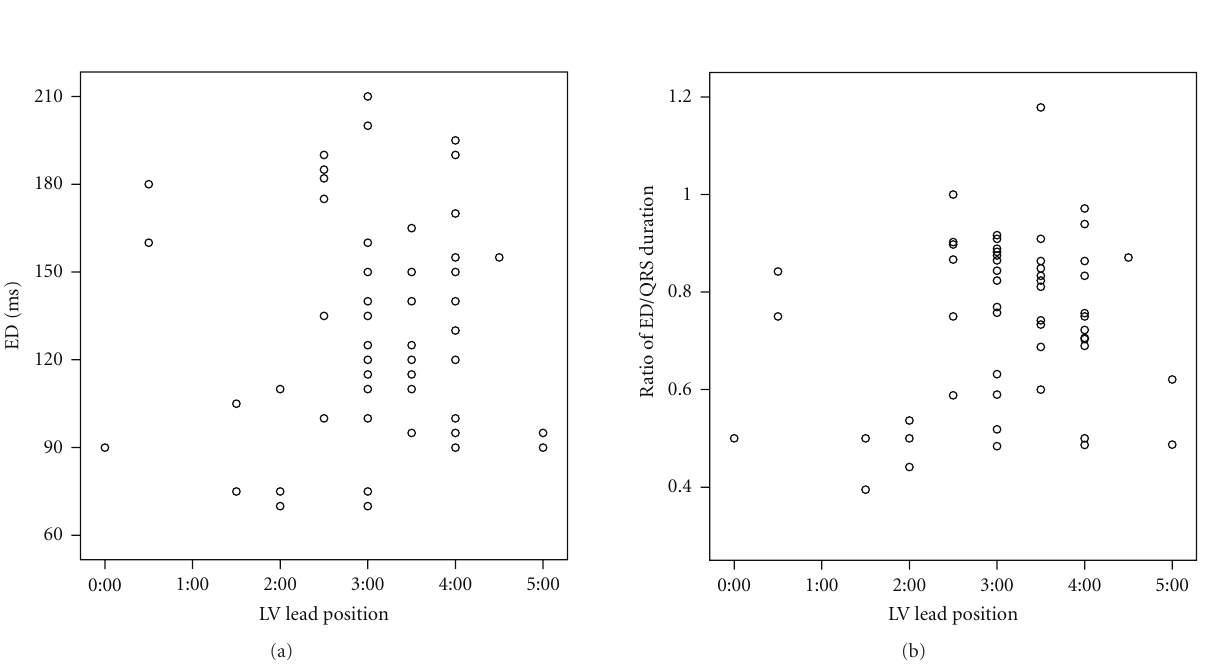
Figure 4: Distribution of ED (a) and ratios of ED/QRS duration (b) as a function of LV lead position in the LAO view. Abbreviations: ED: electrical delay, LAO: left anterior oblique.